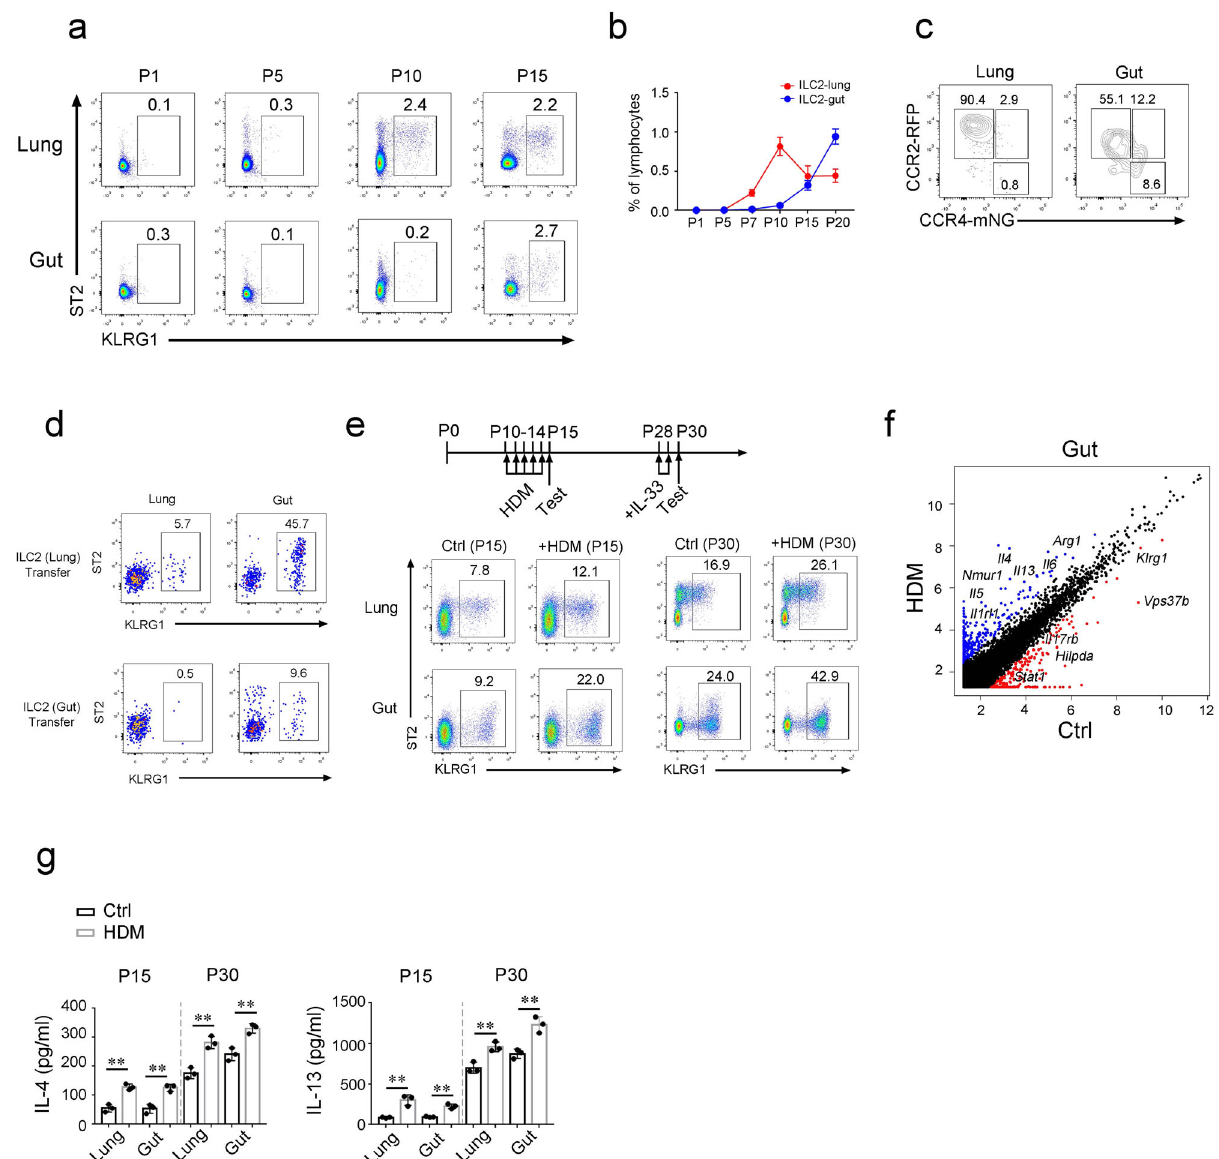
Fig. 6 | Postnatal development of lung ILC2s contributes to the proper func- tion of gut ILC2s. a , b Analysis of lung and gut ILC2s from mice of indicated postnatal(P)daysby fl owcytometryandshowasmean±SD. c ExpressionofCCR2 and CCR4 on ILC2s from CCR2-RFP;CCR4-mNeonGreen mice at postnatal day 12 wasanalyzedby fl owcytometry. d TransferoflungILC2sorgutILC2sisolatedfrom mice at postnatal day 12 to the B-NDG mice. Seven days after transfer, ILC2s from the lung and gut of B-NDG mice were analyzed by fl ow cytometry. e Treatment of HDMatearlyageaffectedthefunctionoflungandgutILC2s.Miceatpostnatalday (P) 10 were i.n. treated with 10 μ g HDM for 5 consecutive days, and lung or gut ILC2sweresubsequentlyanalyzedby fl owcytometry(indicatedasP15).Twoweeks after fi rstround of HDM treatment,micewerei.p. challengedwith 400ng/mouse/